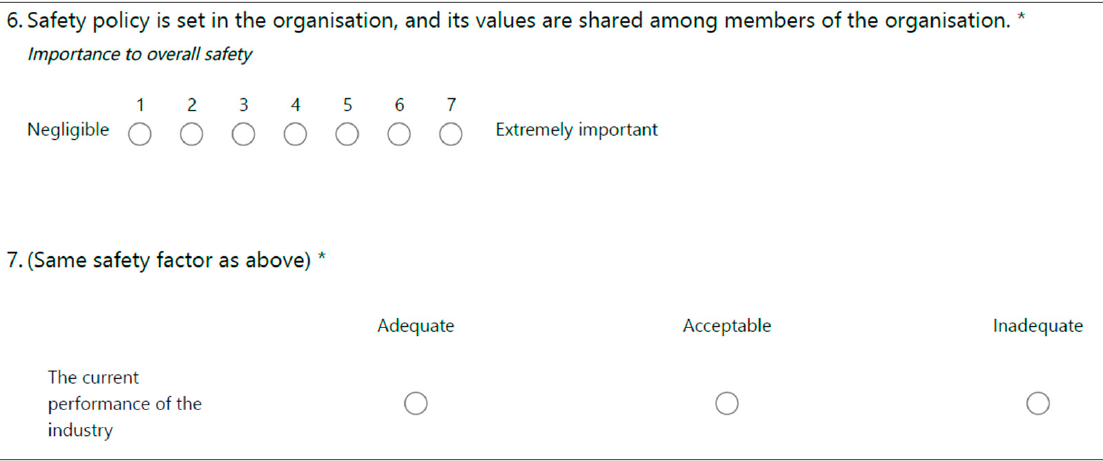
Figure 3. An example of questions for the safety philosophical factors’ indicator (SPFI) of “SC1”.